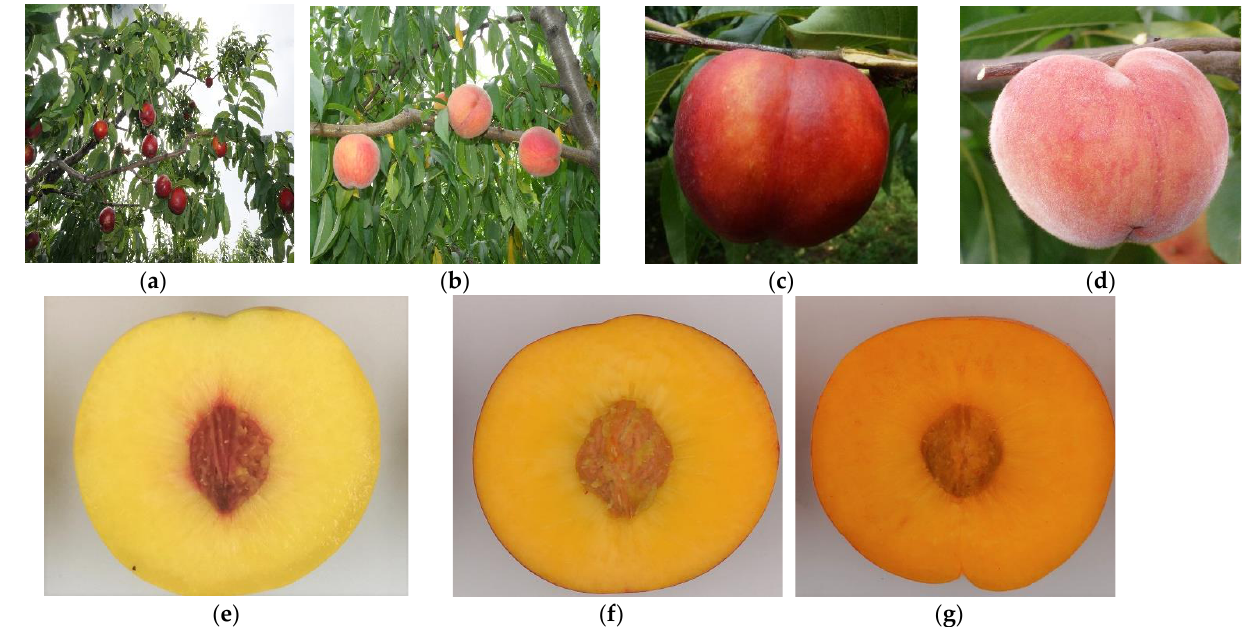
Figure 1. Studied materials of different peach types. ( a ) Peach with shortest fruit developmental period ‘Chaowuyuehuo’ (63 d); ( b ) peach with longest fruit developmental period ‘Shamenlaite’ (151 d); ( c ) peach with glabrous skin ‘Ao19’; ( d ) peach with pubescent skin ‘Beibeile’; ( e ) peach with yellow flesh color ‘Ruiguang2’; ( f ) peach with golden flesh color ‘Zijinhong2’; ( g ) peach with orange flesh color ’TX4F244C’ .